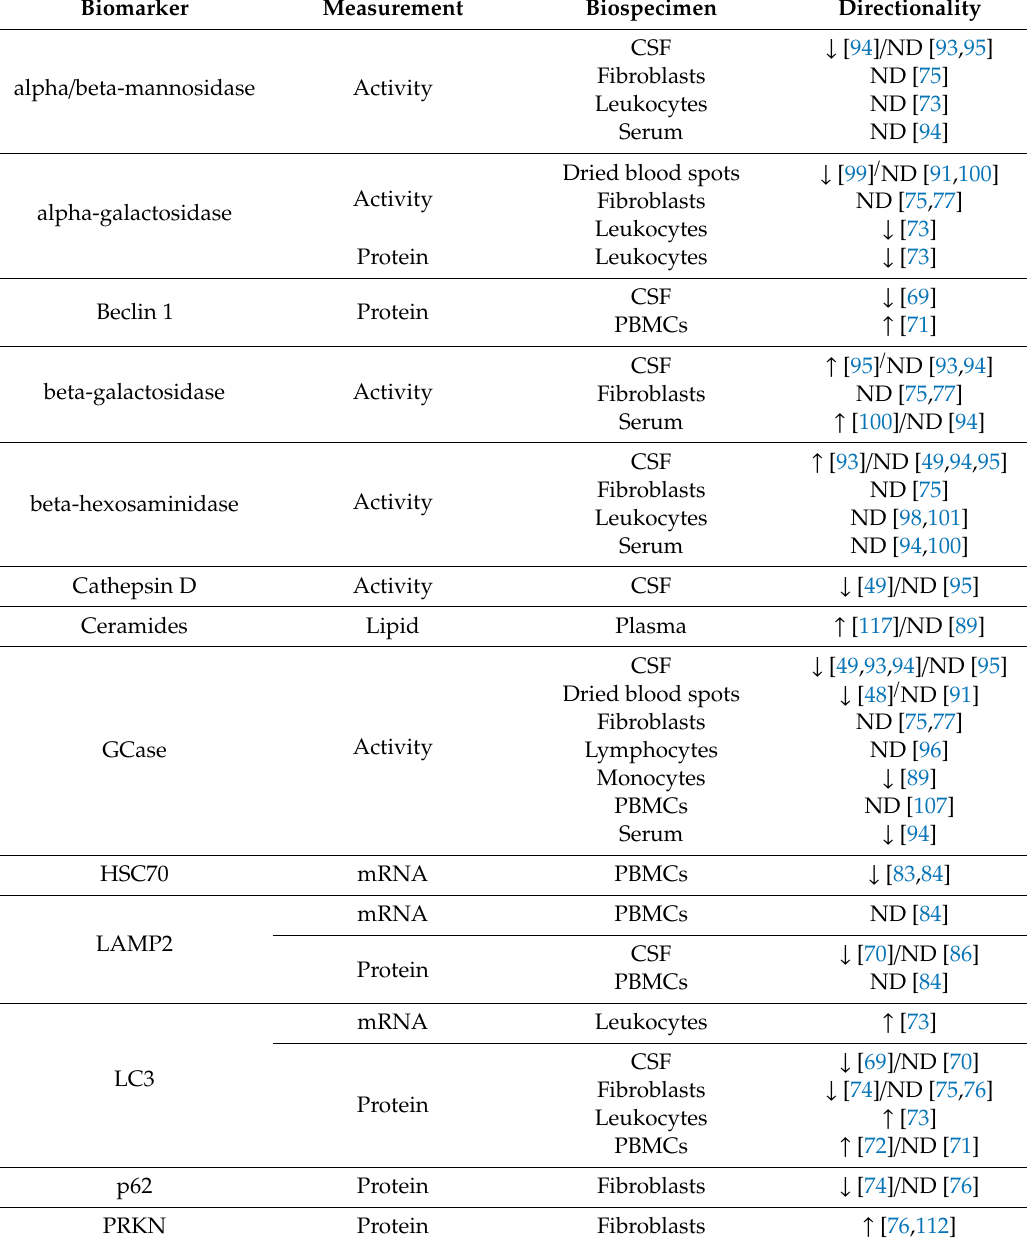
Table 2. Summary of the sPD biomarkers. This table includes only those biomarkers assessed in at least two studies. Directionality in sPD compared to controls is depicted ( ↑ , increased; ↓ ,